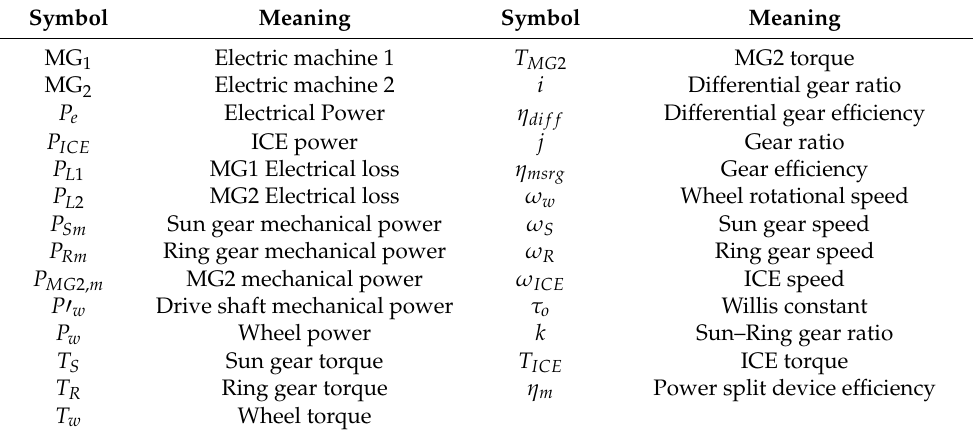
Table 1. Variables